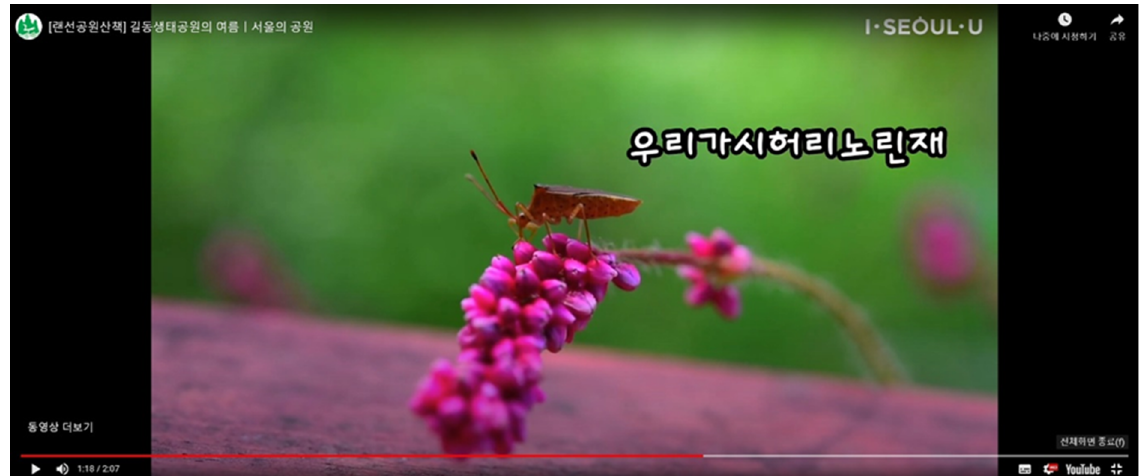
Figure 12. Online program for Gildong Ecological Park (source: Department of Green City, [25]).